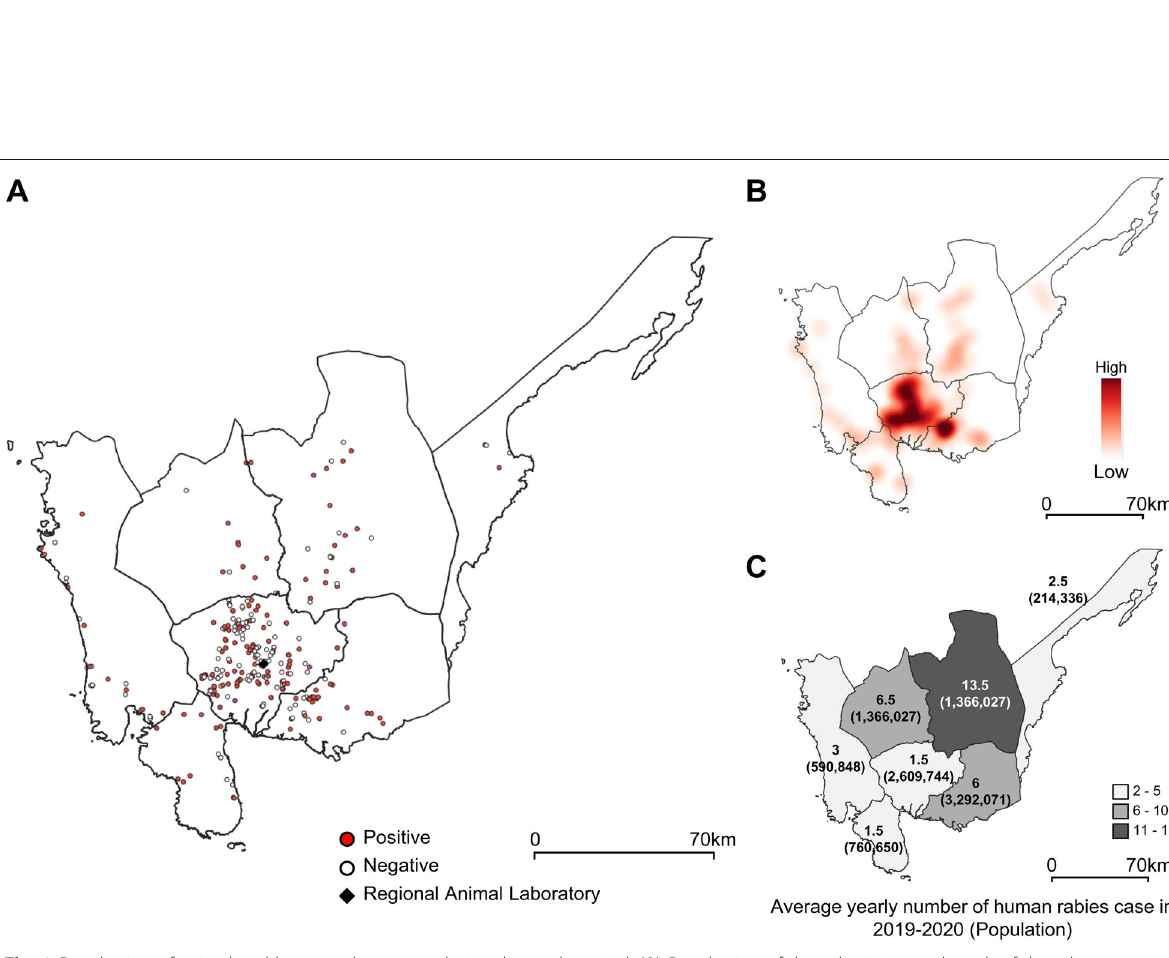
Fig. 3 Distribution of animal and human rabies cases during the study period. ( A ) Distribution of the submission and result of the rabies cases in Region III. ( B ) Heat map indicates the density of positive cases in animal surveillance in Region III. ( C ) Color scale indicates the mean human rabies incidence and population per